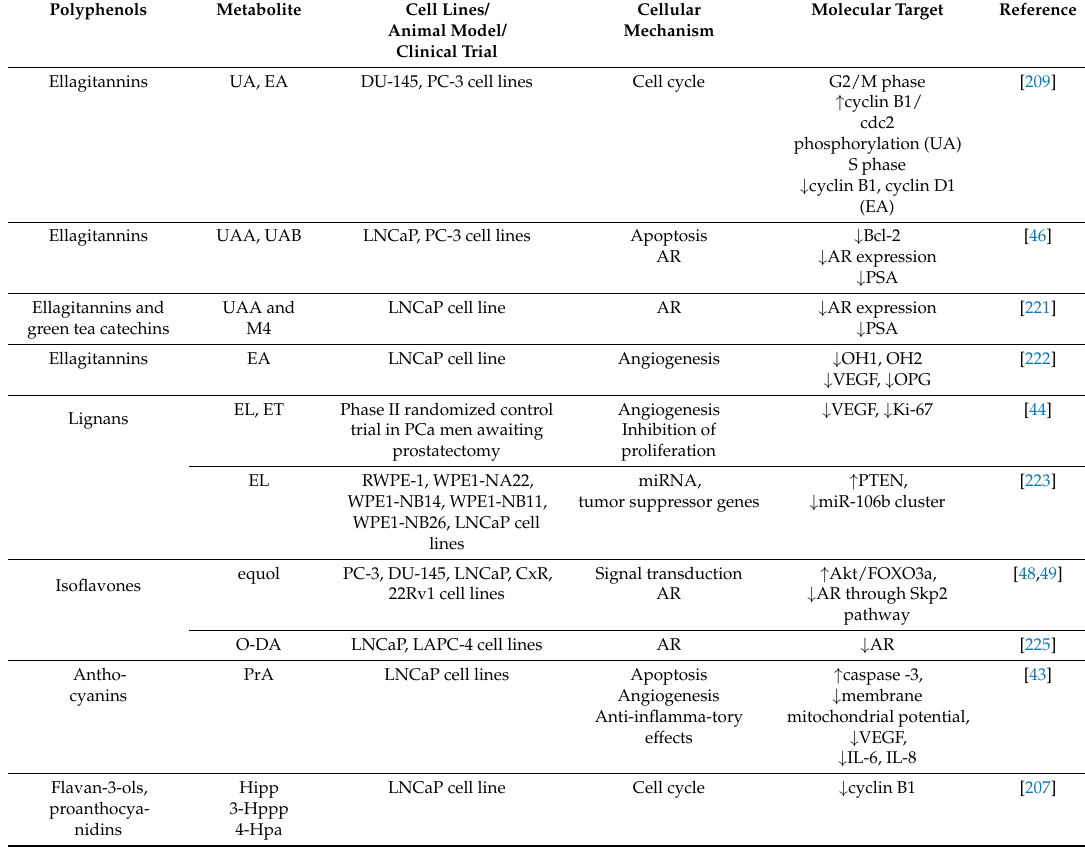
Table 4. Role of polyphenol metabolites in prostate